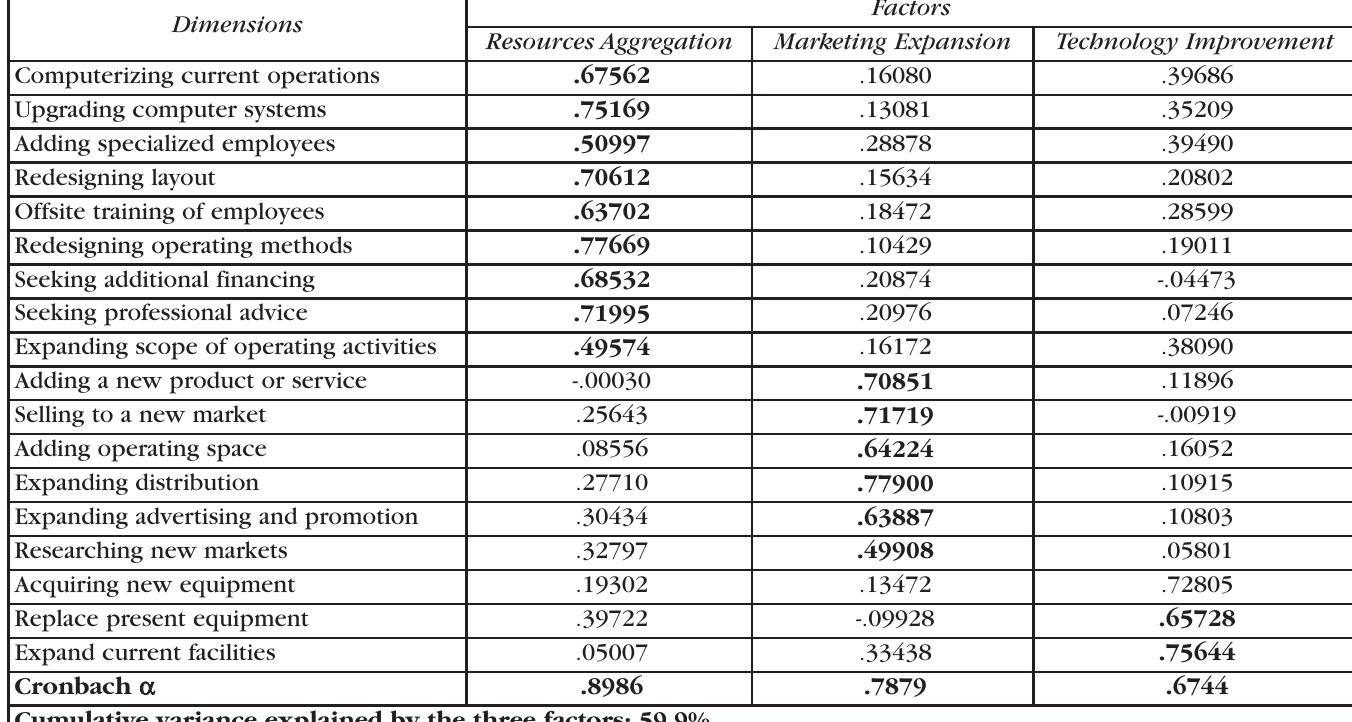
Table 2. Factor Analysis of Entrepreneurial Expansion